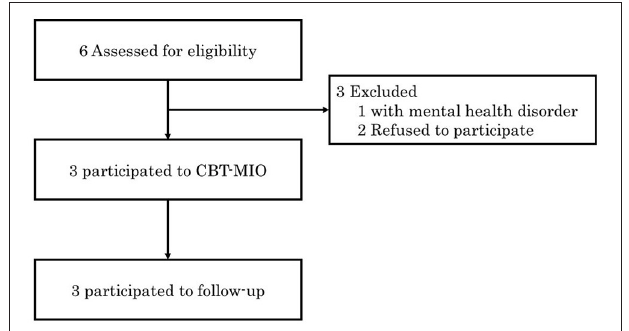
FIGURE 2 | Flow of participants through the pilot study.